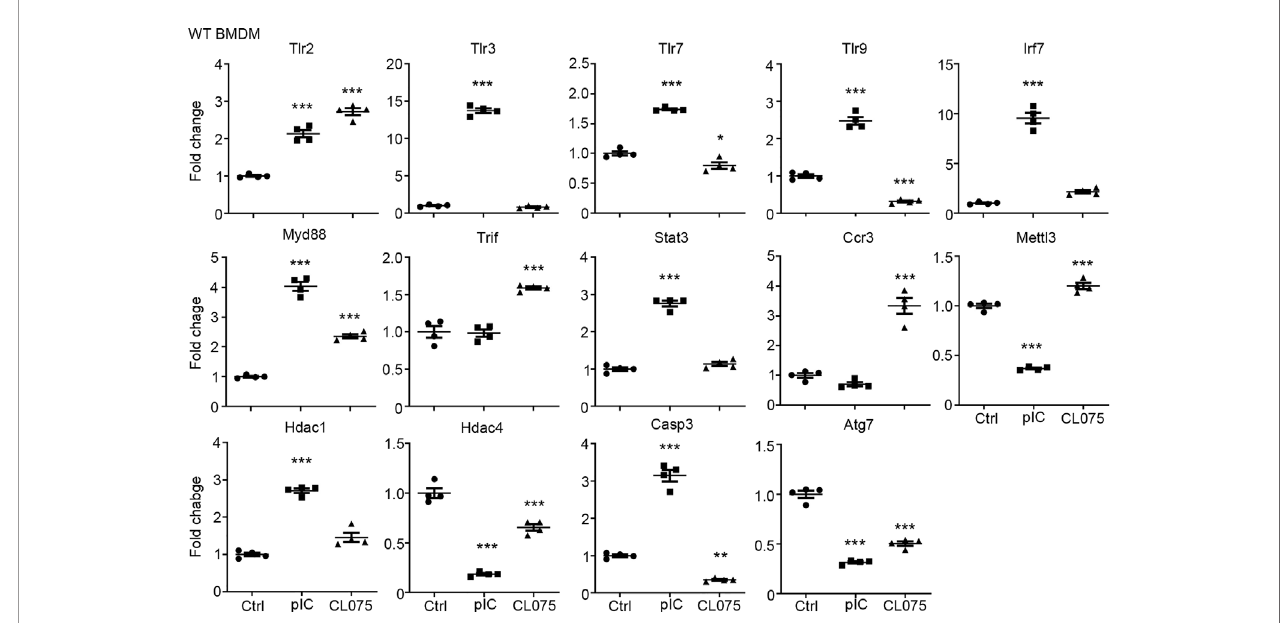
FIGURE 2 | Quantitative RT-PCR con fi rms altered gene expression in response to TLR3 or TLR7 activation. Poly(I:C) and CL075 were used to activate TLR3 or TLR7, respectively, in WT BMDMs. The expression levels of indicated genes were determined by quantitative RT-PCR and normalized against internal control Hprt . Data are represented as mean ± SEM ( error bars ). Each dot indicates the data of one independent experiment. *P < 0.05; **P < 0.01; ***P <